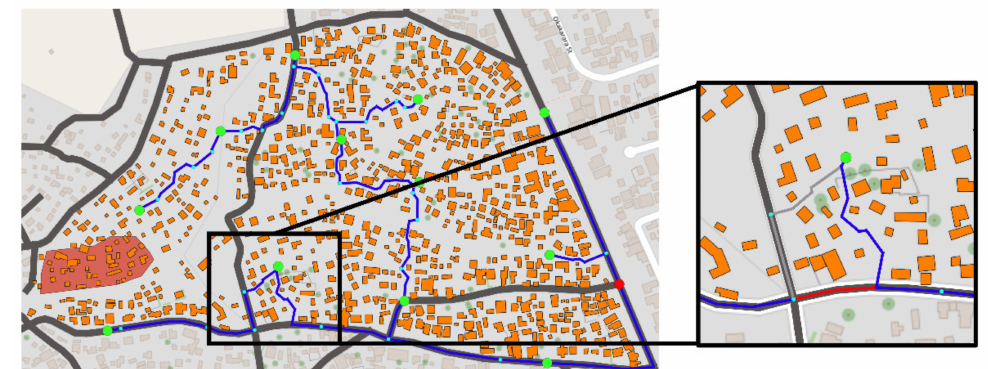
Figure 10. Correction (red) of the generated WDS of the Steiner-Tree-approximation (pipes: blue, water points: green) (basemap and buildings/polygons: